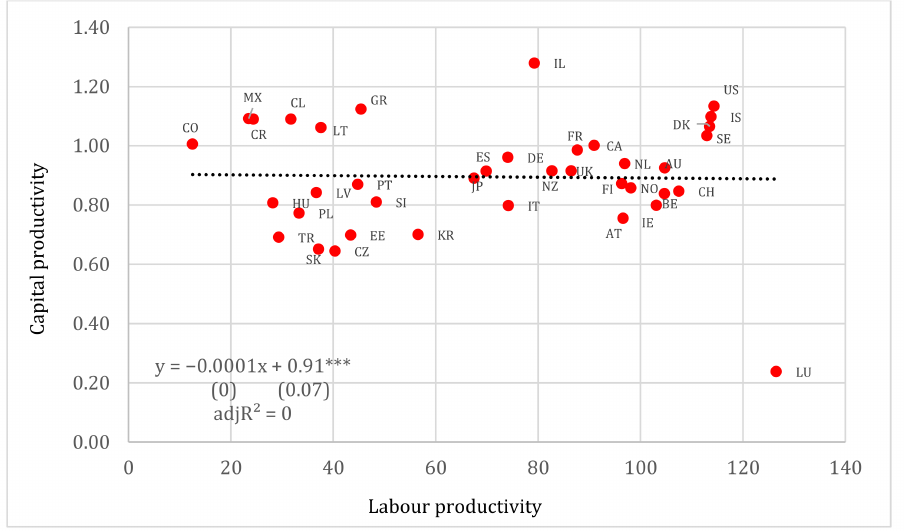
Figure 6. Labour vs. capital productivity. Note: Standard errors reported in parentheses. *** denotes 1% level of statistical